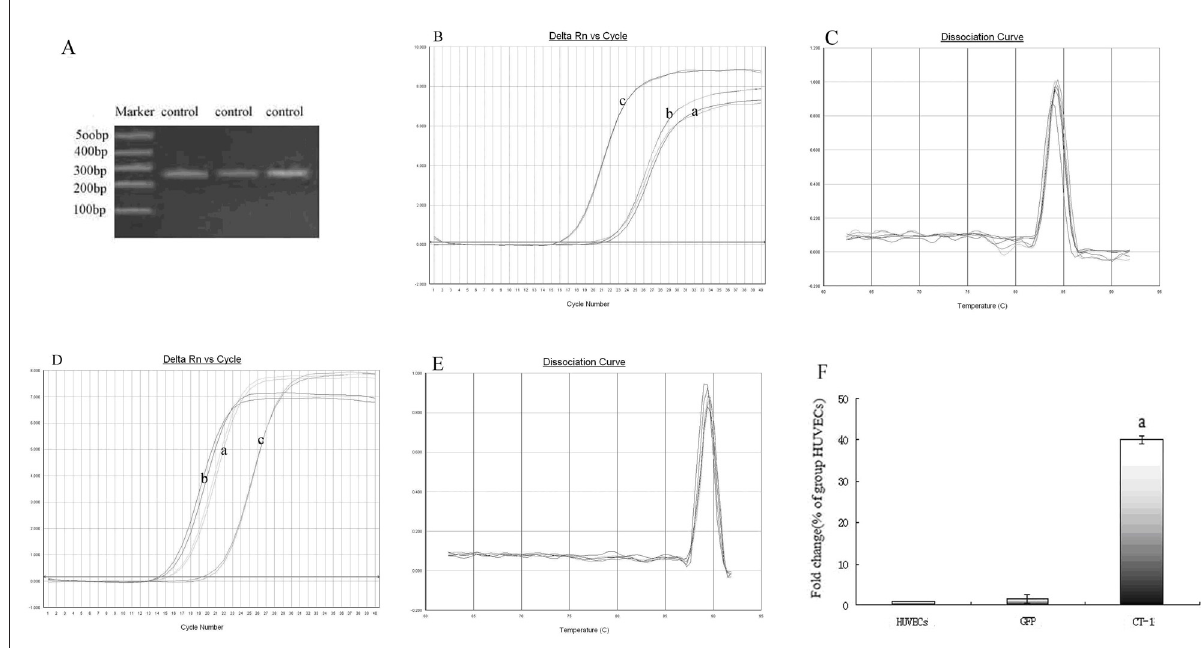
Fig. 1. The expression of CT-1 mRNA after pEGFP-N1-CTF1-GFP transfection. (A) CT-1 PCR product by agarose gel electro- phoresis. (B) CT-1 Gene amplification curve. (C) CT-1 gene dissolution curve. (D) β-actin Gene amplification curve. (E) β-actin gene dissolution curve. (F) The results of 2 -△△Ct ·a-HUVEC group, b-GFP group c-CT-1 group a P <0.05 vs HUVECs